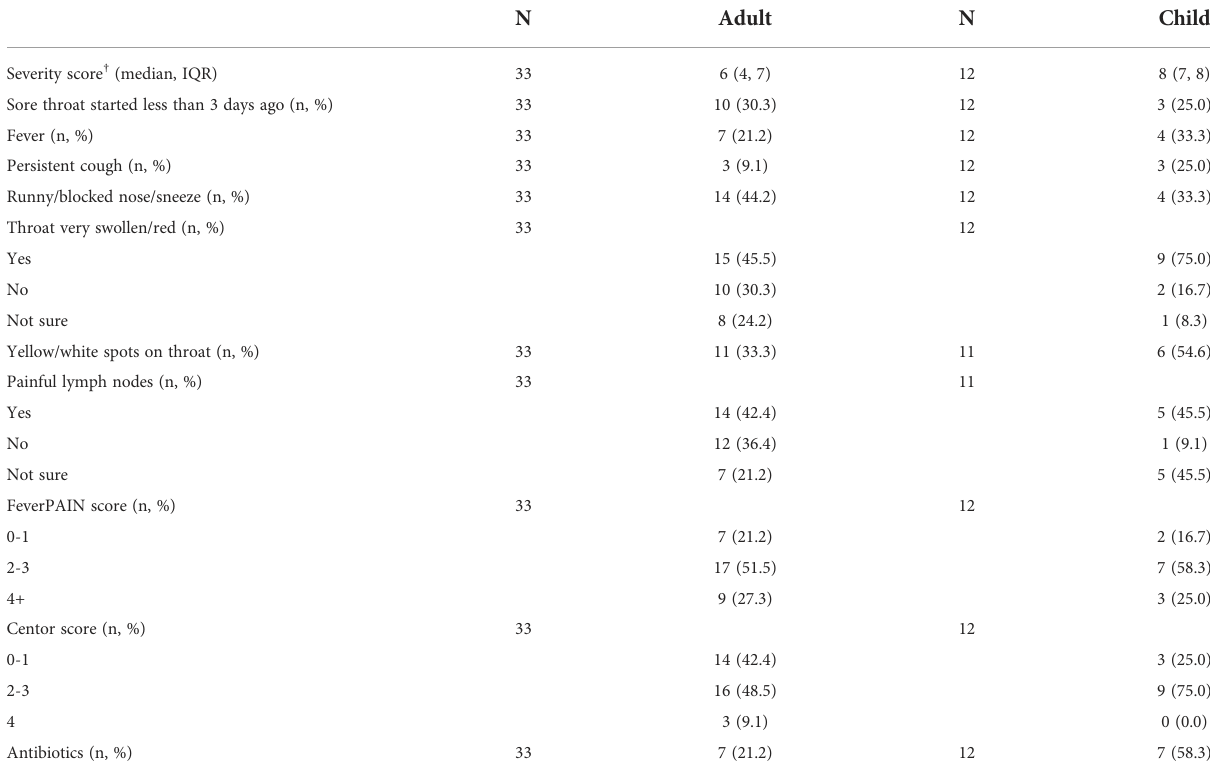
TABLE 2 Clinical